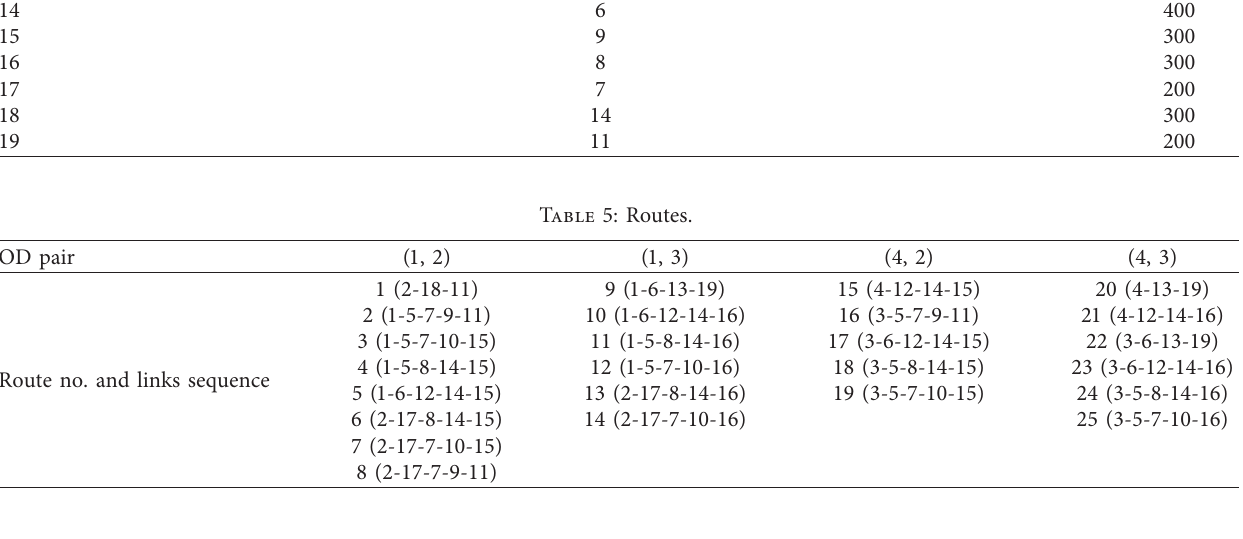
Table 6: Basic numerical settings on Nguyen-Dupuis network.